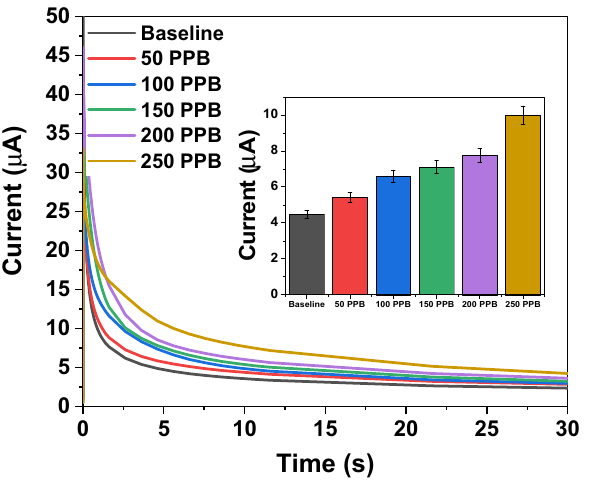
Figure 3. Chronoamperometry scan was performed at + 1 V for 30 s on the EMIM[BF 4 ] modified interdigitated electrode (IDE) for the target analyte. Calibrated dose response chronoamperogram for NO concentration ranging from 50 to 250